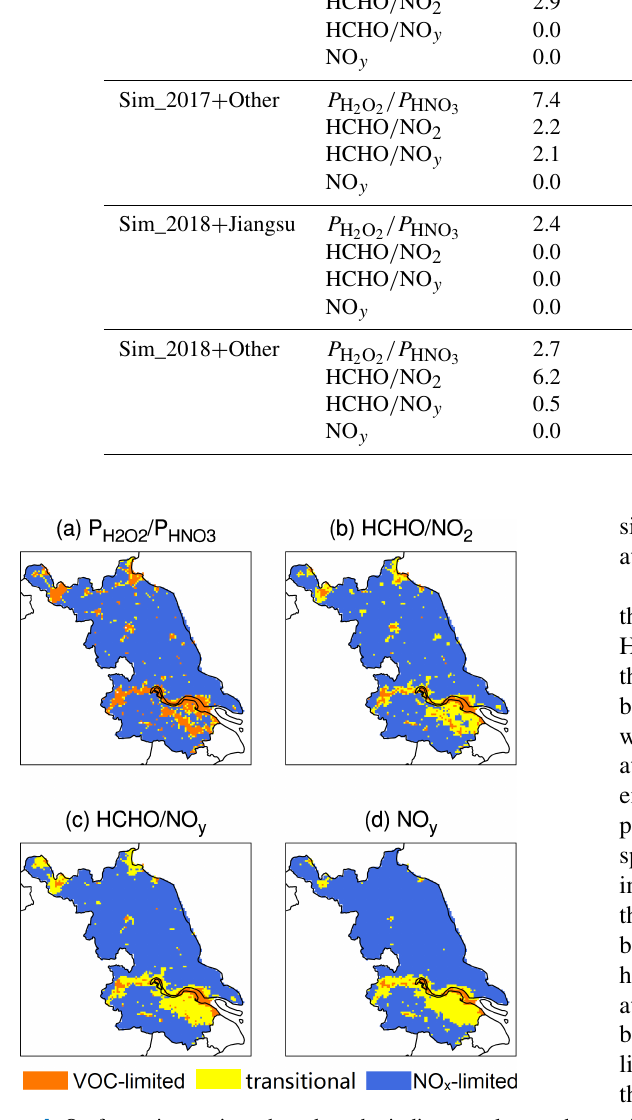
Figure 4. O 3 formation regimes based on the indicator values and thresholds in Table 3. The orange indicates a VOC-limited regime. The blue indicates a NO x -limited regime. The yellow is associated with a transitional